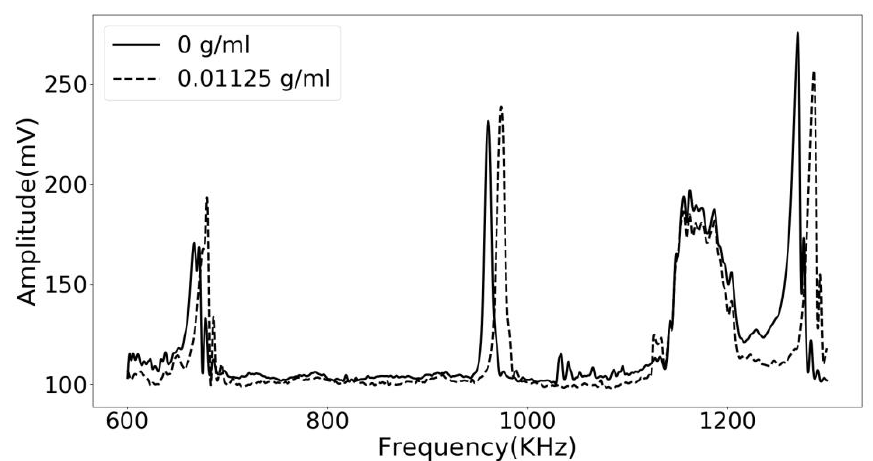
Figure 4. Experimental results of the phononic crystal sensor using distilled water (solid line) and a lithium carbonate solution with a concentration of 0.01125 g/mL (dashed line).